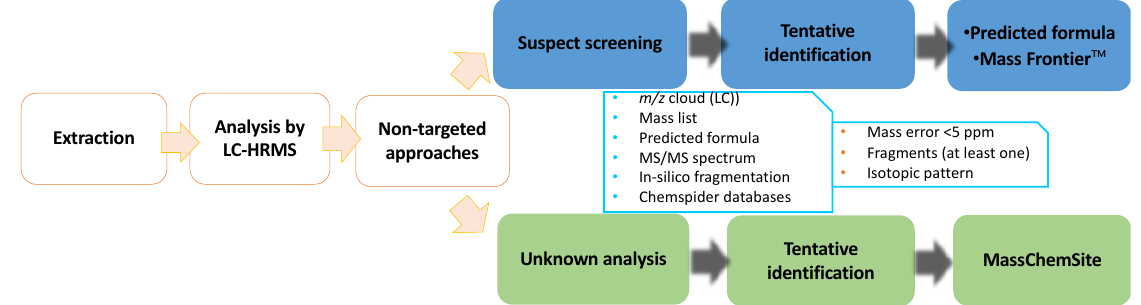
Figure 2. Workflow applied to the identification of metabolites by liquid chromatography-high resolution mass spectrometry (LC-HRMS).